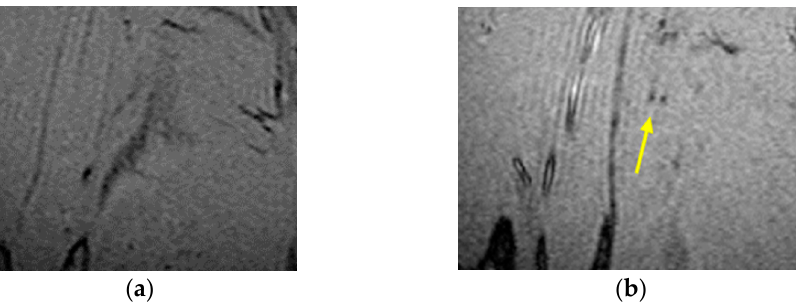
Figure 1. MR images of the mouse calf region ( a ) lacking IO-NPs and ( b ) with IO-NPs, as black dots in the image pointed by yellow arrow.